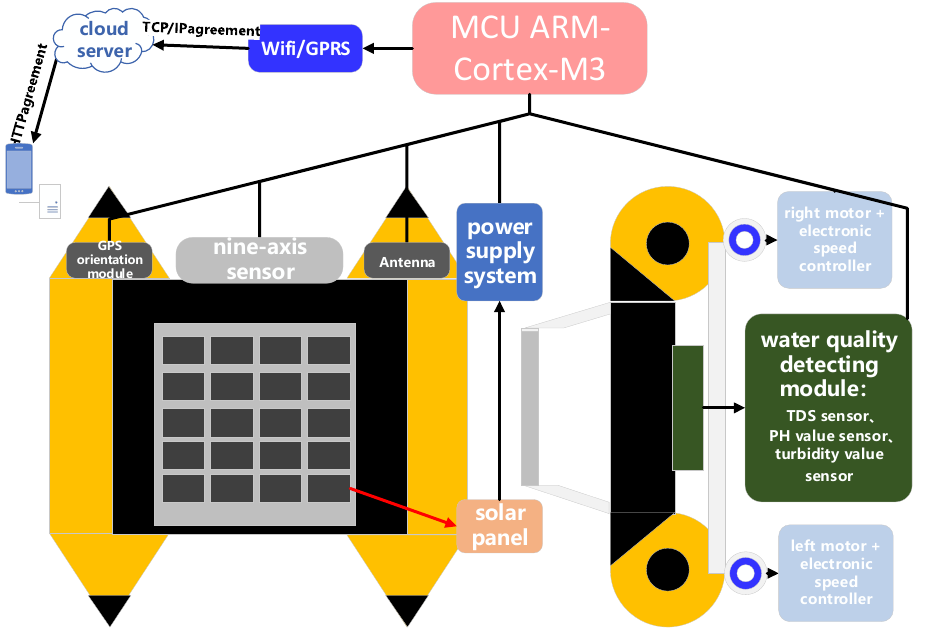
Figure 2. The overall architecture design of the unmanned service vehicle (USV). GPRS, general packet radio service; MCU, micro control unit; GPS, global position system; TDS, total dissolved solids; ARM, advanced reduced instruction-set c omputer machine .